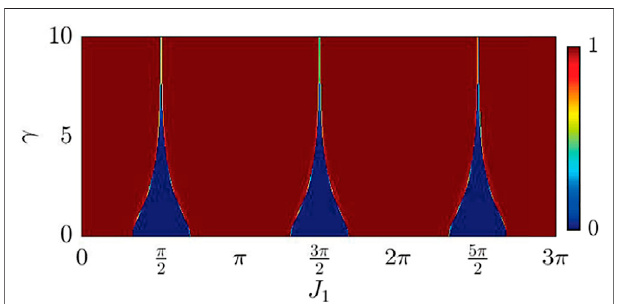
FIGURE 7 | Complete topological phase diagram of eight-step non- unitary coinless DTQWs characterized by the topological invariant W versus the coupling parameter J 1 and the gain-loss parameter γ